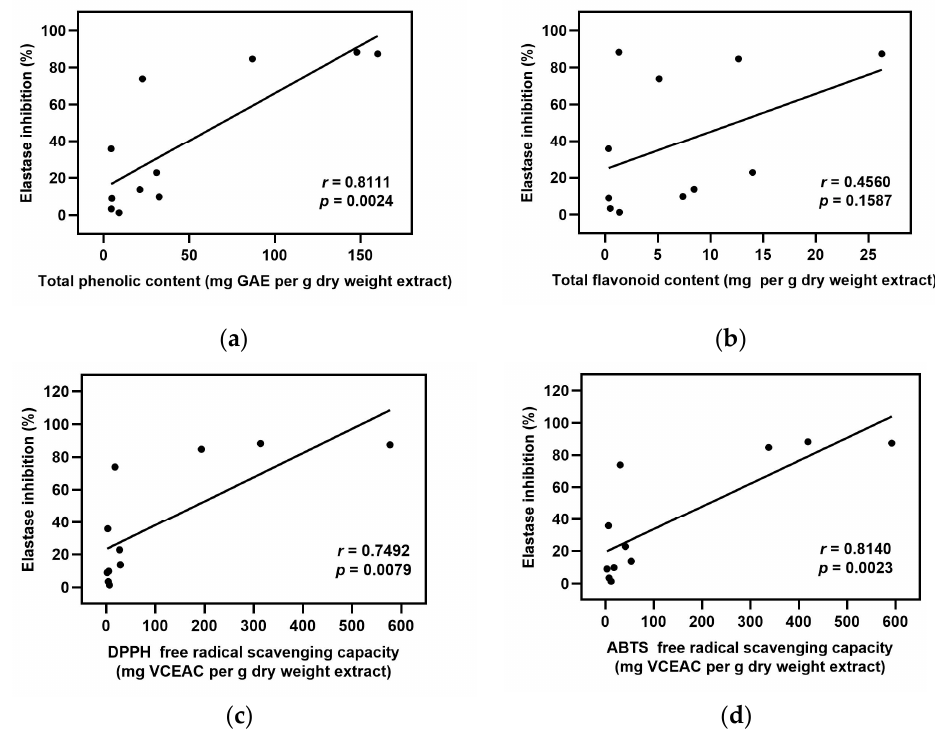
Figure 1. Correlation analysis between elastase inhibition and values in Tables 1 through 4 were expressed as Pearson’s correlation coefficients ( r ): ( a ) elastase inhibition versus total phenolic content; ( b ) elastase inhibition versus total flavonoid content; ( c ) elastase inhibition versus DPPH free radical scavenging activity; ( d ) elastase inhibition versus ABTS free radical scavenging activity.